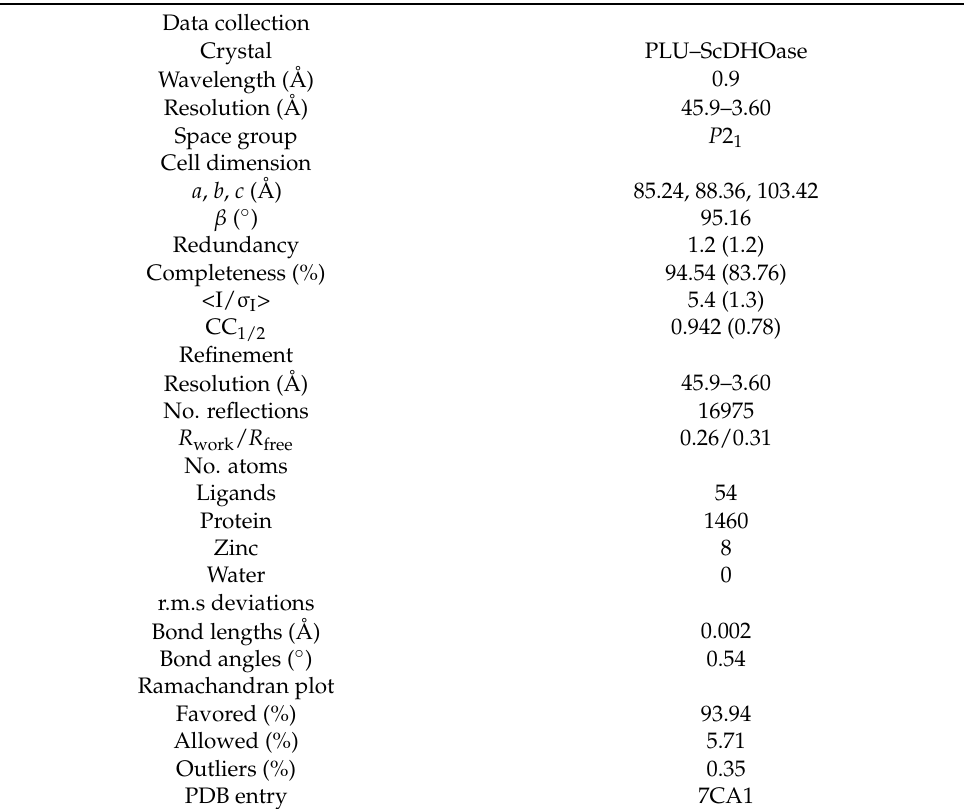
Table 1. Data collection and refinement